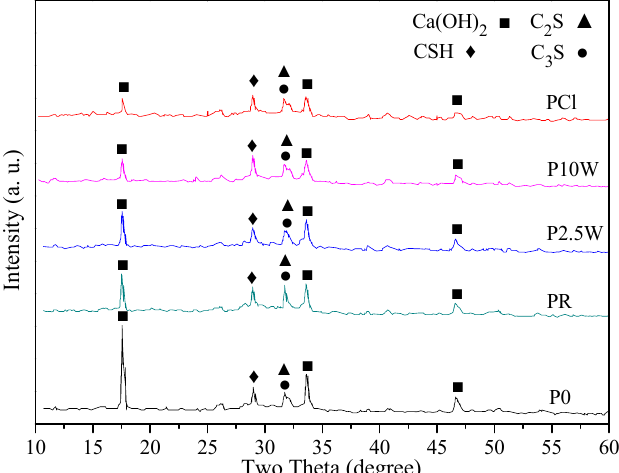
Figure 10. XRD patterns of RHA cement paste at the age of seven days.